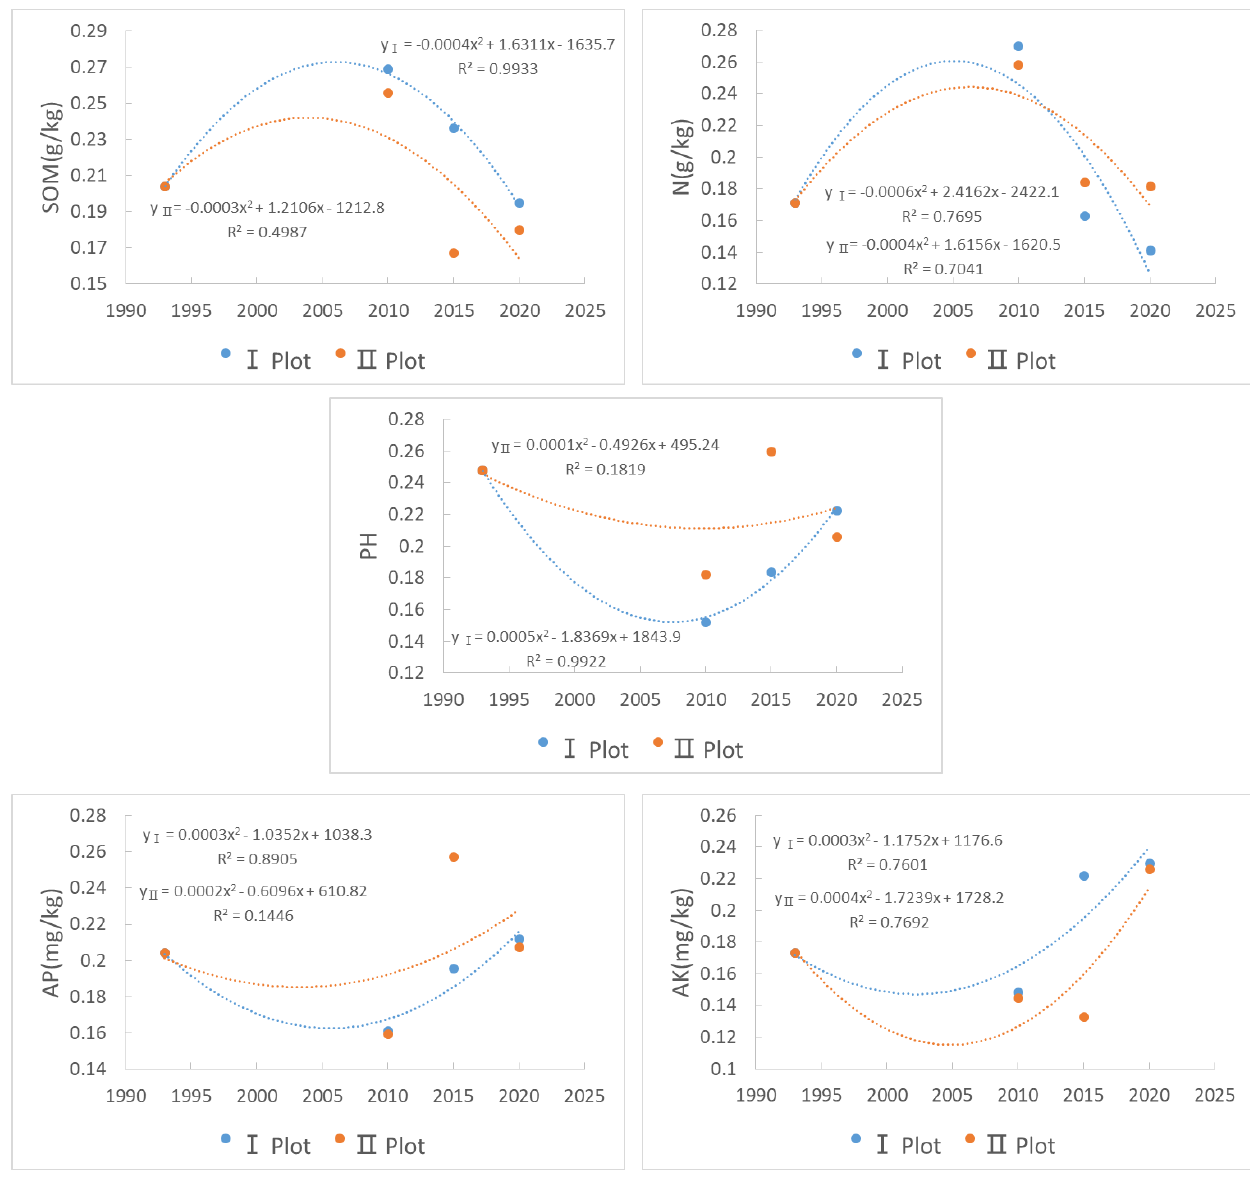
Figure 9. Dynamic score of Soil Quality Index.